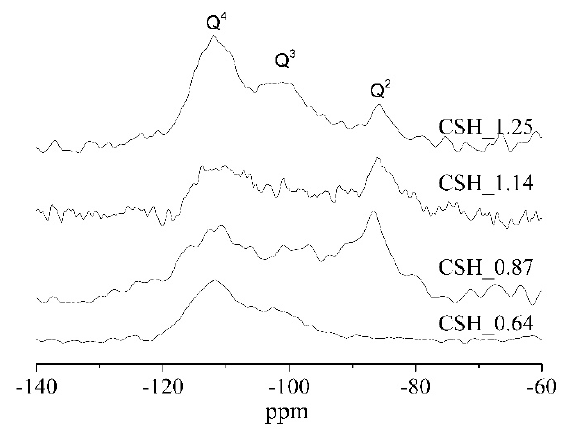
Figure 5. 29 Si NMR spectra of C-S-H after carbonation for 28 days.